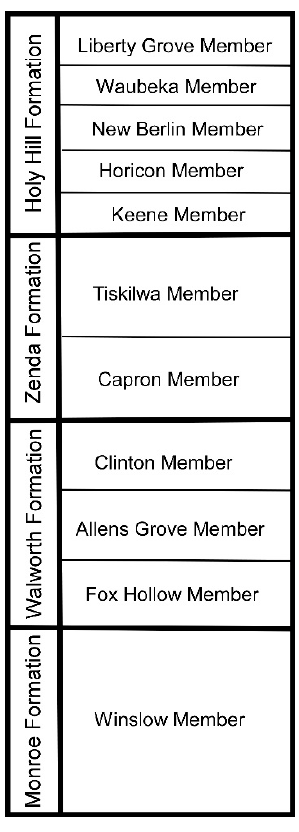
Figure 2. Stratigraphic column of Quaternary sediment units in Wisconsin [20].